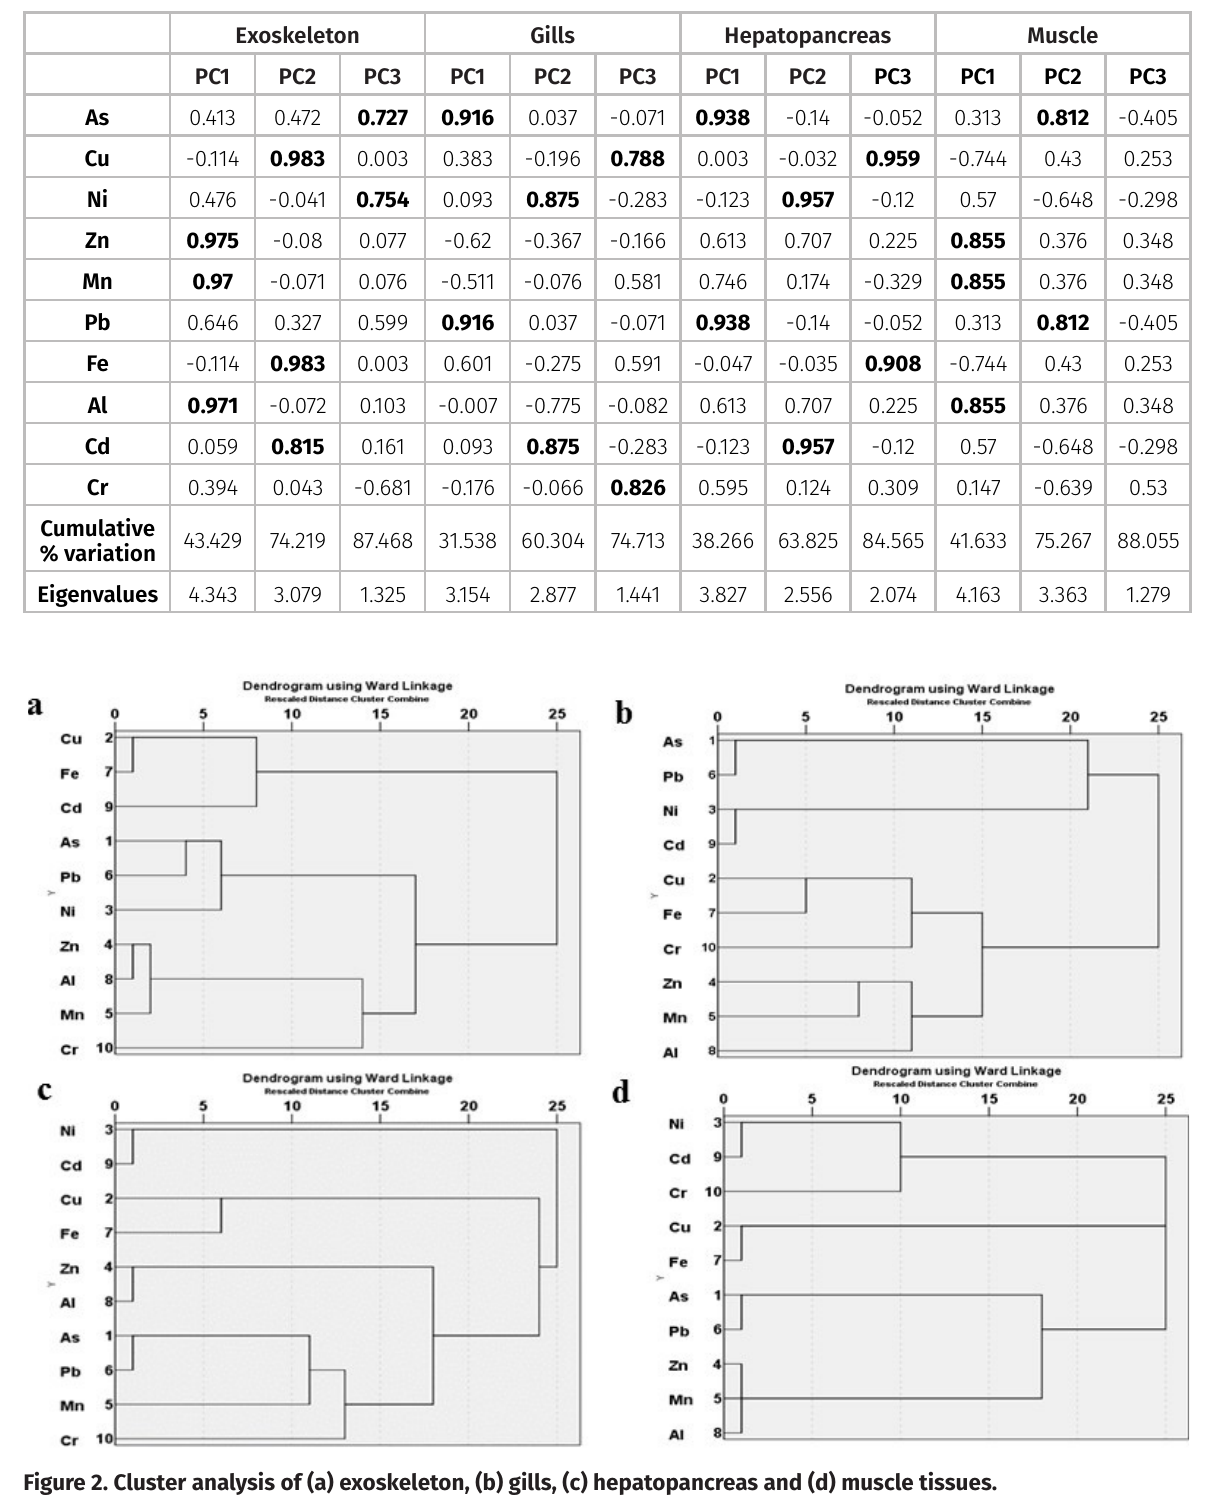
Figure 2. Cluster analysis of (a) exoskeleton, (b) gills, (c) hepatopancreas and (d)